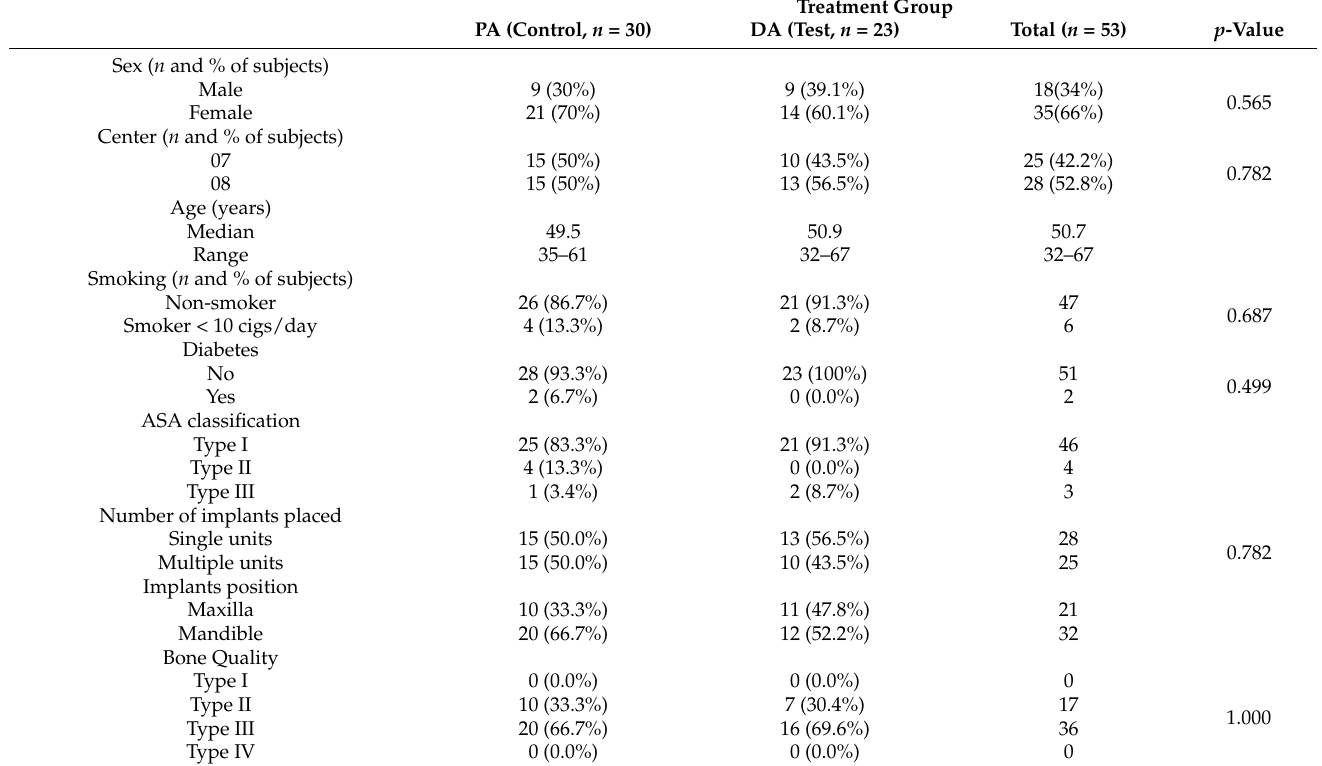
Table 1. Baseline demographic characteristics of the study